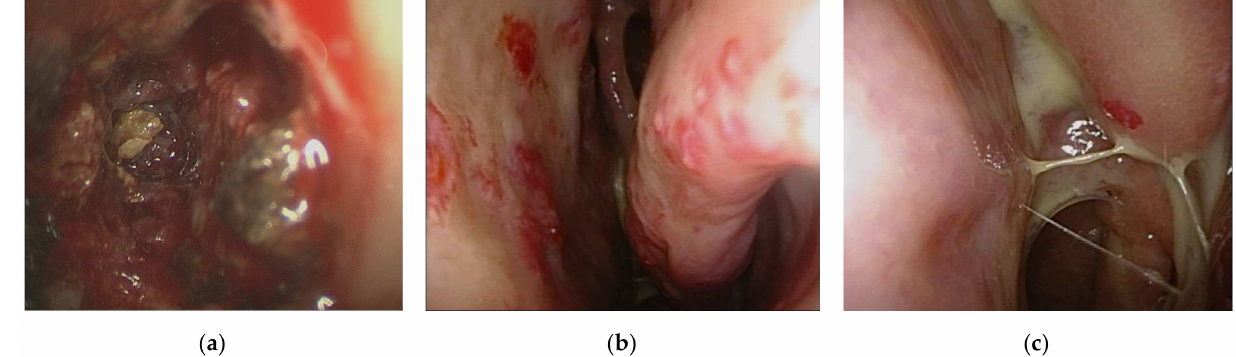
Figure 2. Caldwell Luc operation and sphenoidectomy. ( a ) Discharge, debris, and tumor like materials in sphenoid sinus. ( b ) Mucosal petechiae and left middle nasal conchae. ( c ) Left inferior nasal conchae.